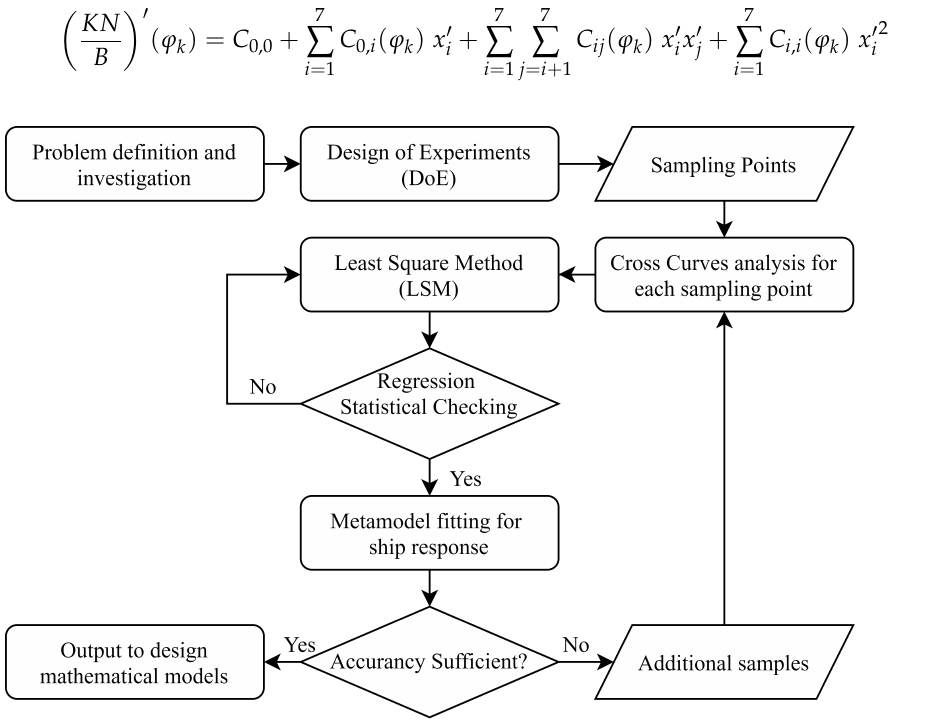
Figure 3. Framework for Metamodels.